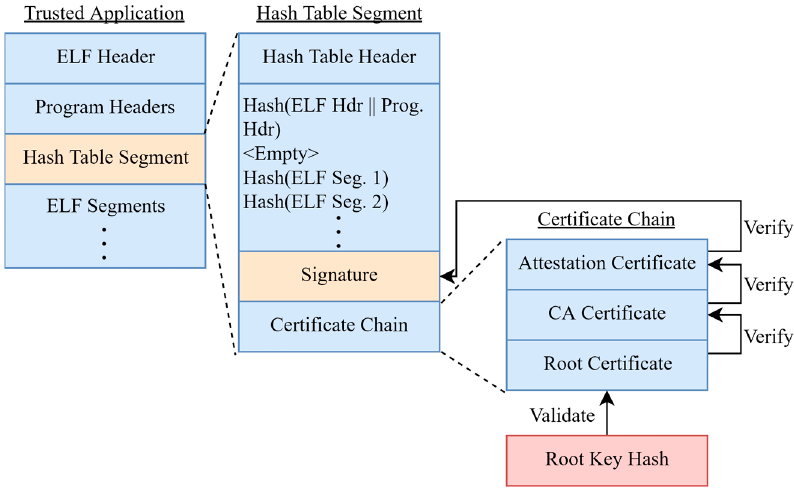
Figure 4. Architecture of a QSEE Trusted Application.